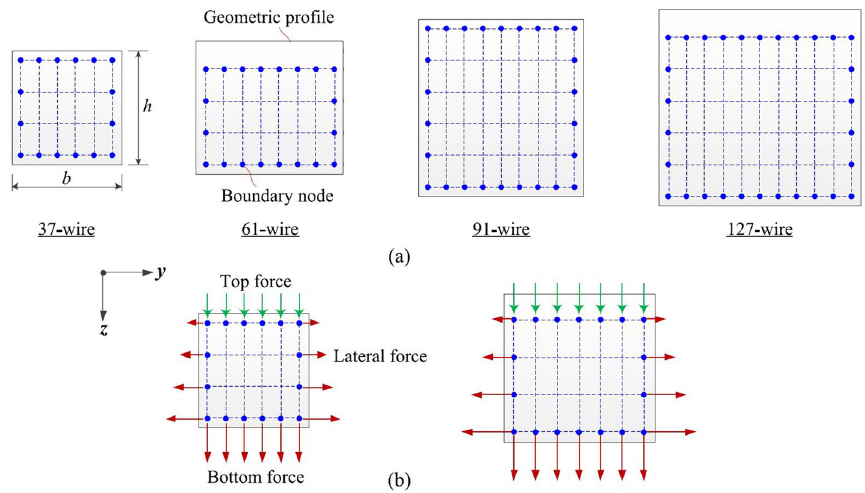
Fig.13 Strand element method for the lateral pressure between the main cable and the saddle